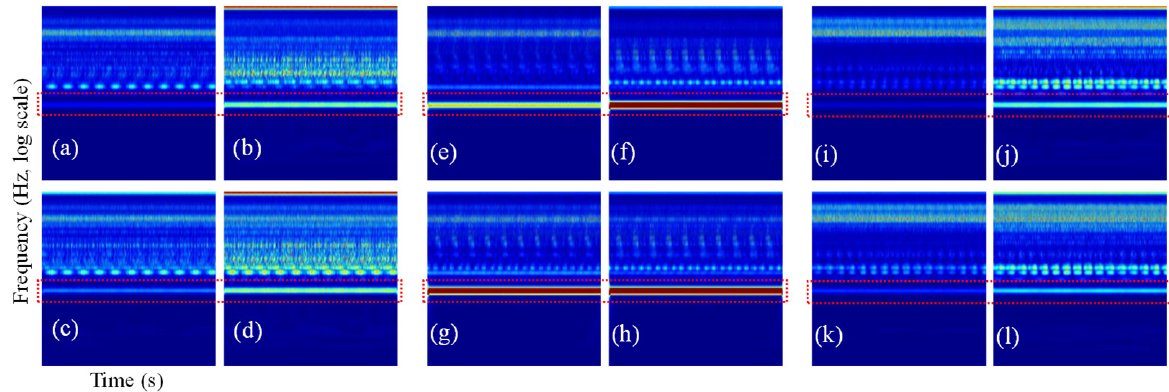
Figure 5. Scalograms of different healthy states for the original and augmented data: ( a ) normal original x ; ( b ) normal original y ; ( c ) normal virtual x v at π /8; ( d ) normal virtual x v at π /4; ( e ) unbalance original x ; ( f ) unbalance original y ; ( g ) unbalance virtual x v at π /8; ( h ) unbalance virtual x v at π /4; ( i ) vertical misalignment original x ; ( j ) vertical misalignment original y ; ( k ) vertical misalignment virtual x v at π /8; ( l ) vertical misalignment virtual x v at π /4. (The horizontal line in the red rectangle shows the speed of rotation at steady state).